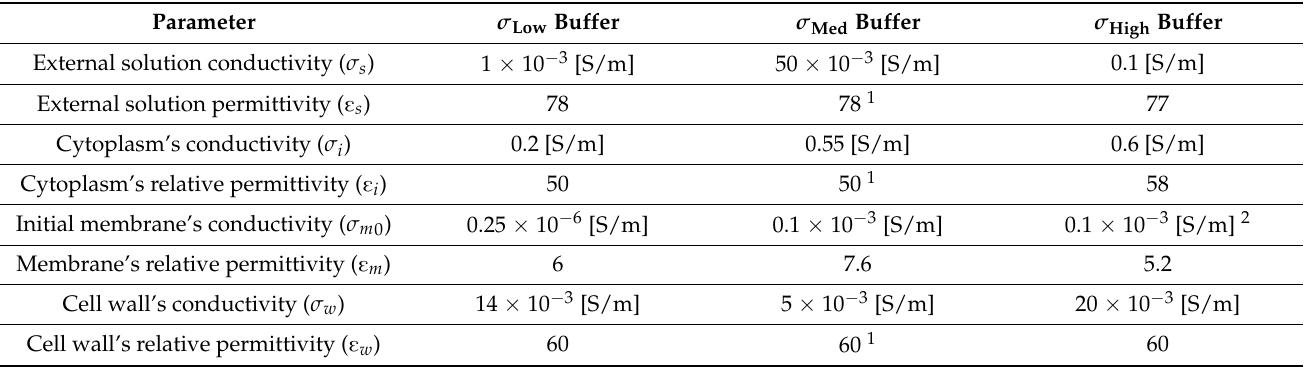
Table 2. Non-linear electroporation model, electrical and geometric parameters of the